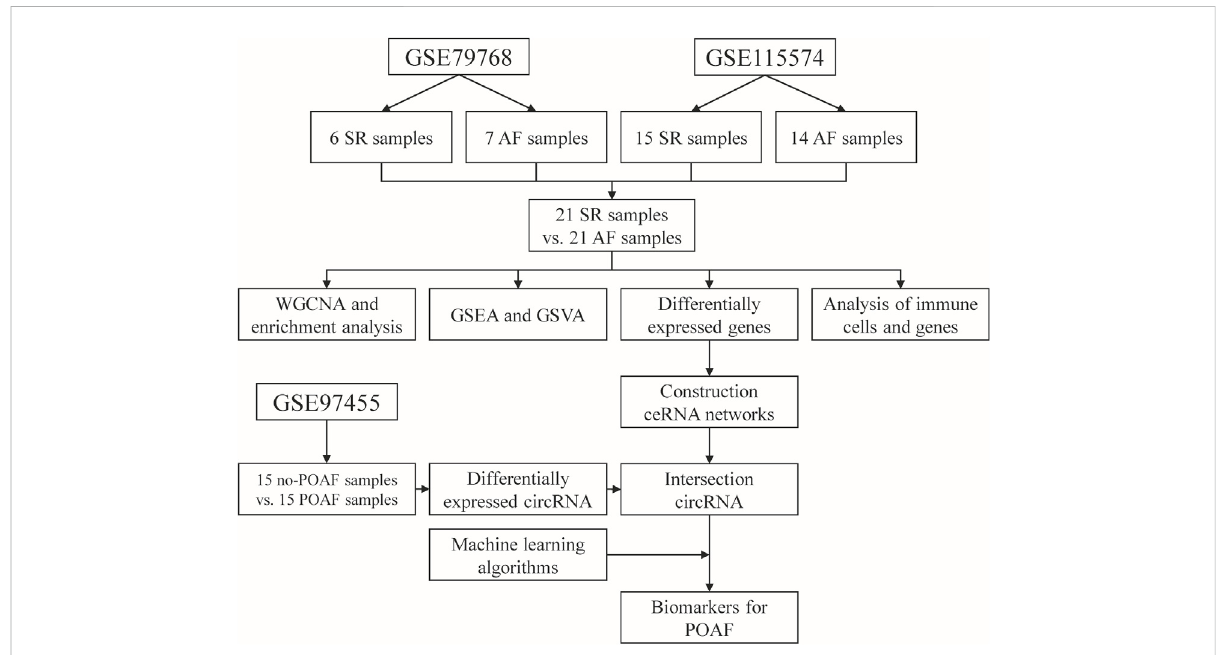
FIGURE 1 Flow chart diagram for the analysis process in this study. SR: sinus rhythm, AF: atrial fi brillation, POAF: postoperative atrial fi brillation, WGCNA: weighted gene correlation network analysis, GSEA: gene set enrichment analysis, GSVA: gene set variation enrichment analysis, ceRNA: competing endogenous